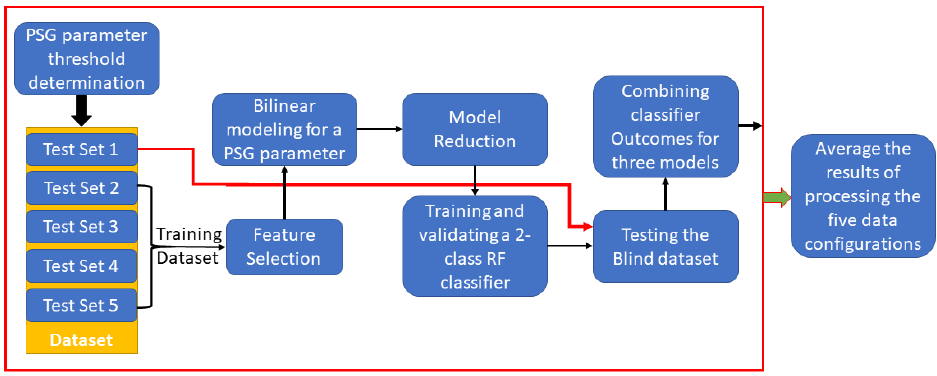
Figure 1. The general flow chart of the process.